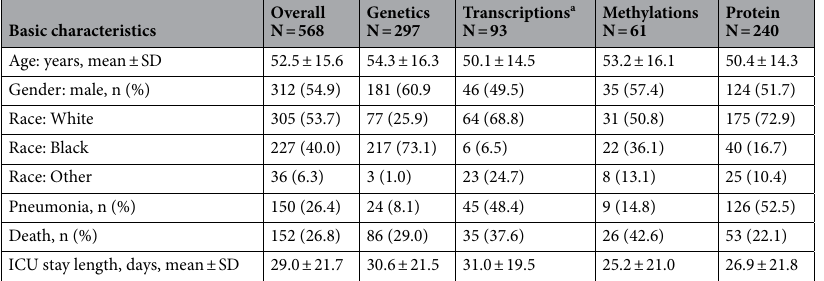
Table 1. Basic characteristics for the study population stratified by each ‘omics’ type. SD standard deviation, ICU intensive care unit. a Transcriptions including RNA microarray and RNA-sequencing data.